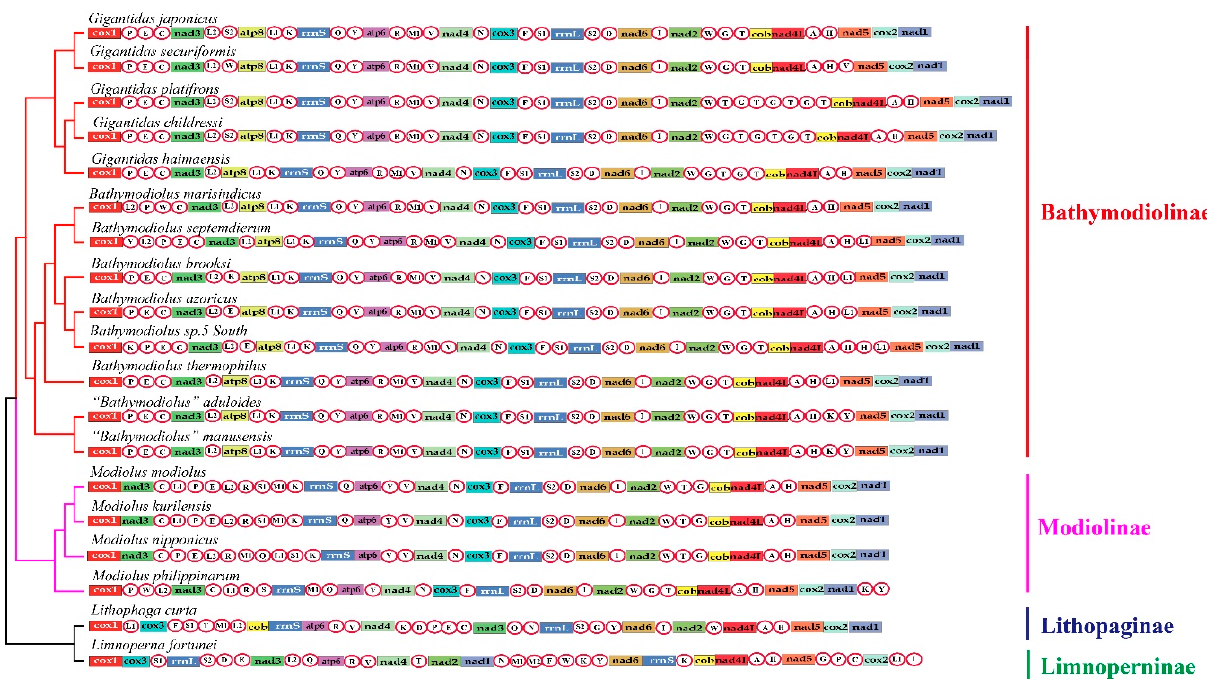
Figure 1. Linearized mitochondrial gene arrangement patterns of the investigated species superimposed on the phylogenetic tree. Gene and genome size are not in scale. The tRNAs are labeled by single-letter abbreviations of the amino acid code. Table 1. Complete mitochondrial genomes used for phylogenetic analysis in this study.